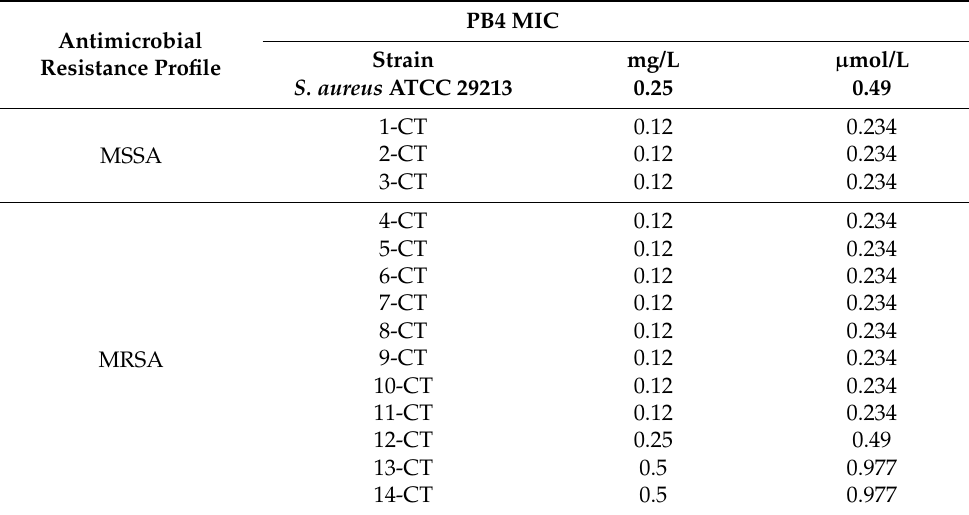
Table 1. Activity of PB4 on S. aureus ATCC 29213 control strain and on 14 clinical S. aureus strains (3 MSSA and 11 MRSA).